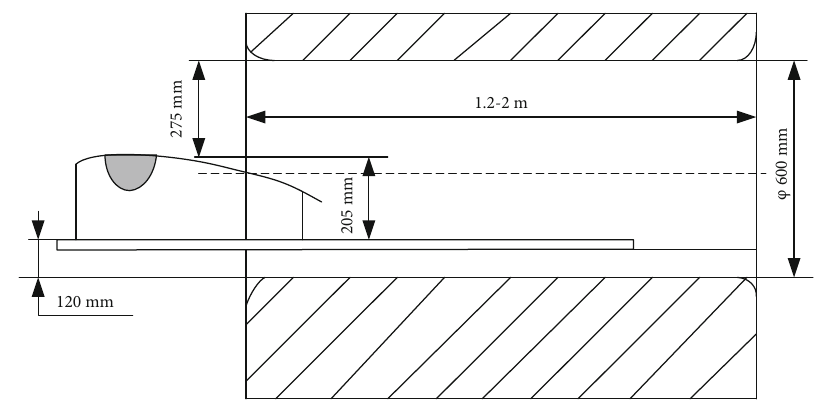
Figure 1: Available space for breast interventional robot under MRI.